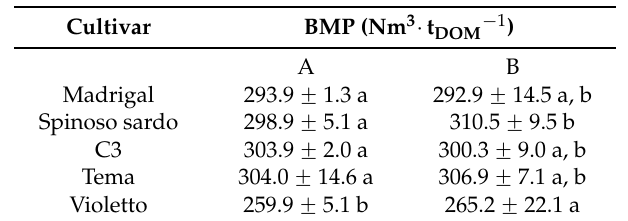
Table 3. BMP testing report (A = wet basis; B = wet basis with catalytic enzymes). Means in columns followed by different letters differ ( p <